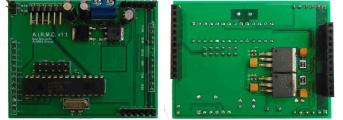
Figure 6. Motor control board: and back side.